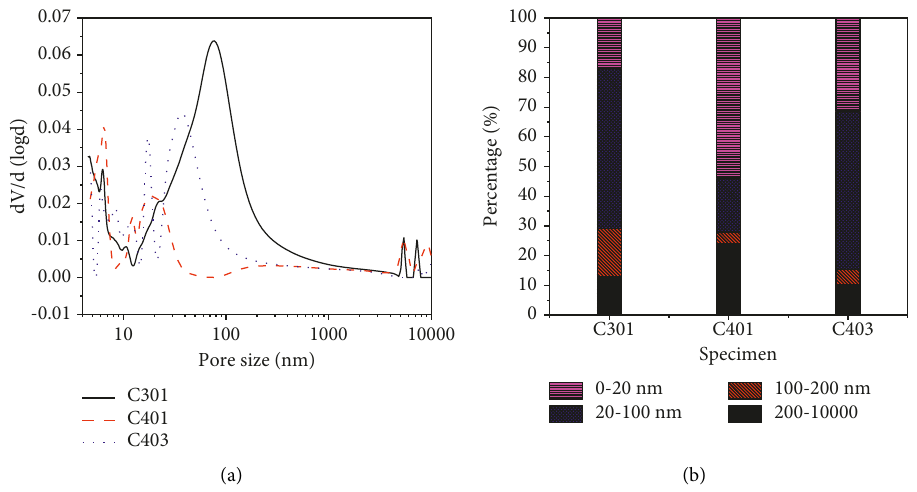
Figure 12: Pore characteristics: (a) pore size distribution and (b) percentage of different pores. Table 4: Scaling of concretes with different strength grades after 6 F - T